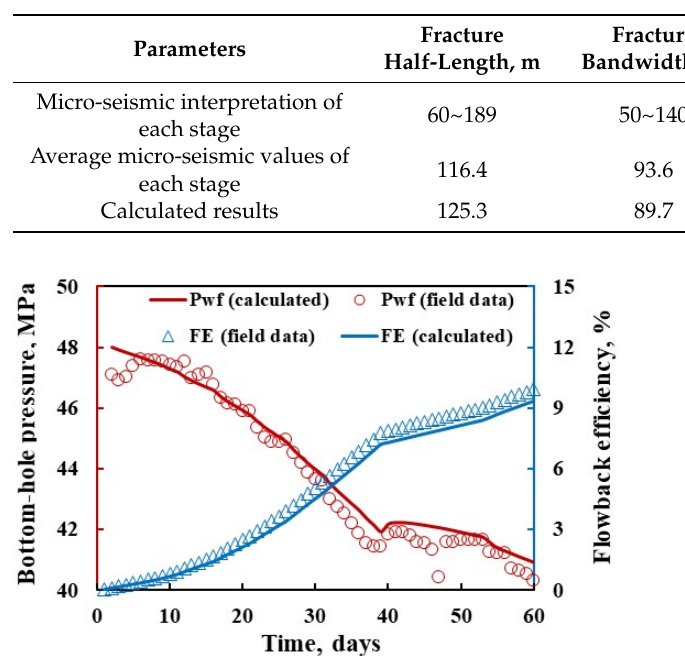
Figure 4. History-match results of bottom-hole pressure and flowback efficiency.